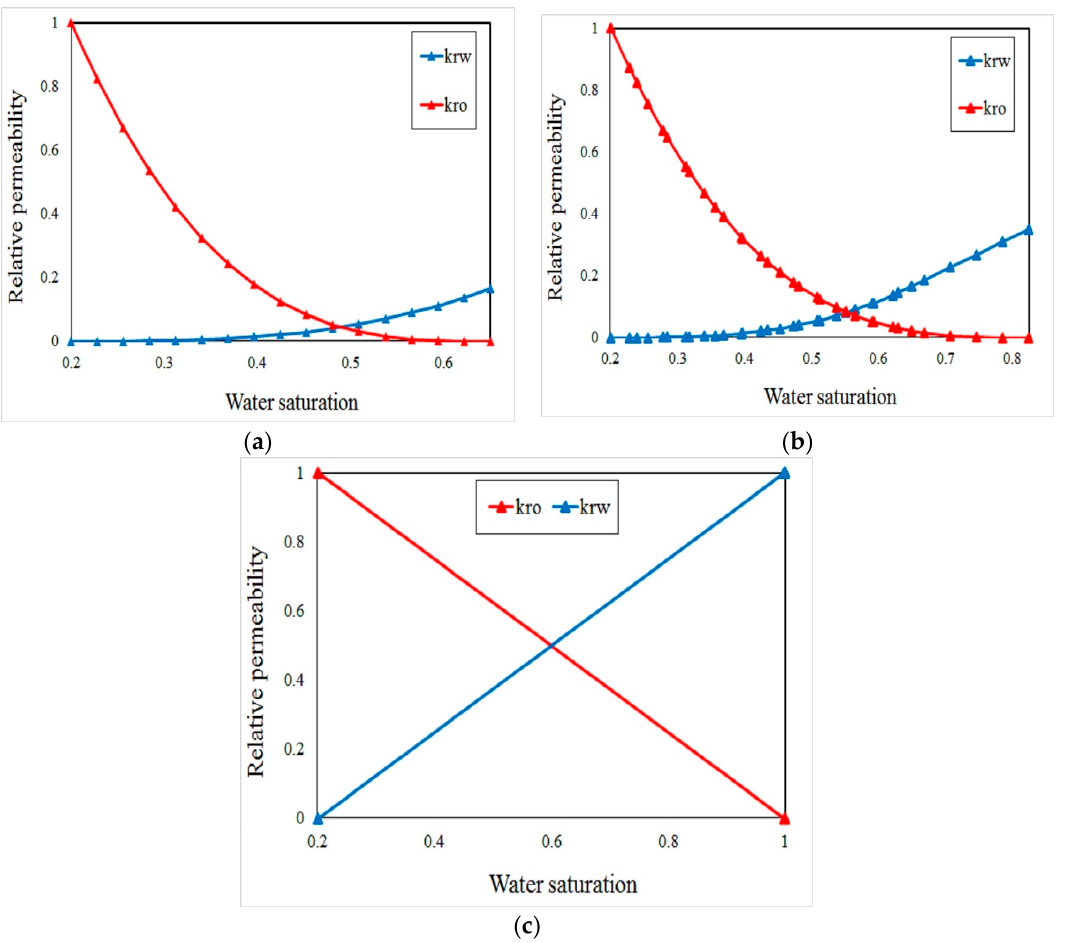
Figure 1. Relative permeability curves at: ( a ) low; ( b ) intermediate; and ( c ) high capillary number.